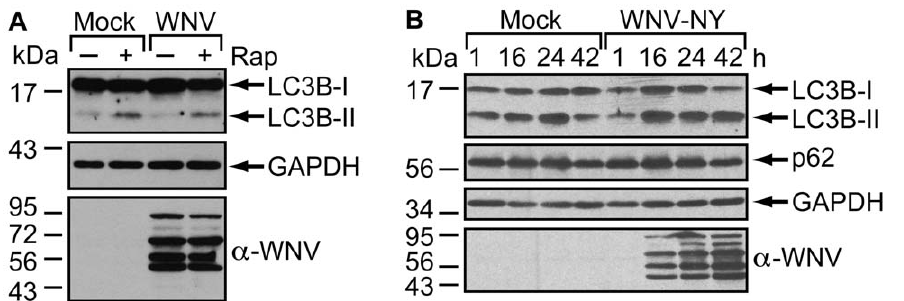
Figure 4. WNV does not interfere with autophagy induction. (A) Effect of WNV infection on rapamycin-induced LC3B-II accumulation. Mock- and WNV-NY- (MOI=3) infected 293T monolayers were treated with rapamycin (rap) at 16 hours post-infection. Whole cell lysates were prepared 8 hours post-treatment with rapamycin and subjected to immunoblot analysis for expression of LC3B (top), GAPDH (middle), and WNV (bottom). (B) Effect of WNV infection on steady-state levels of LC3B-II in A549 cells. A549 monolayers were mock-infected or infected with WNV-NY (MOI=3) in the absence of protease inhibitors. Whole cell lysates prepared at the indicated times (h) post-infection were subjected to immunoblot analysis for expression of LC3B (top panel), p62 (second panel), GAPDH (third panel), and WNV (bottom panel).